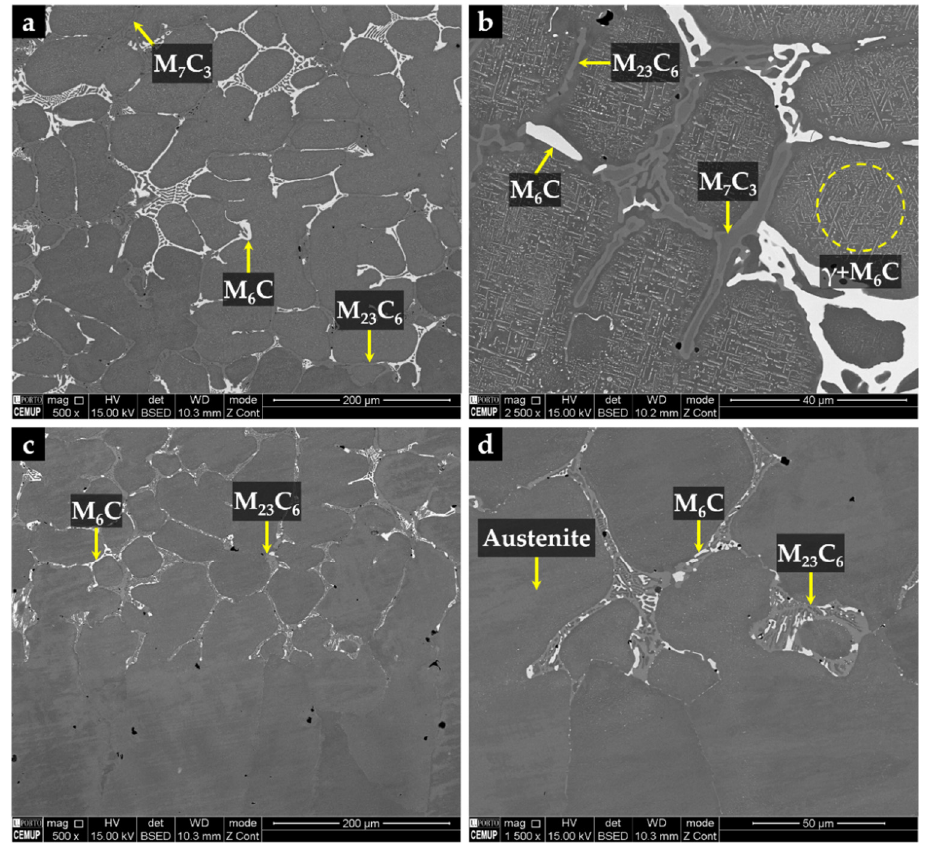
Figure 20. SEM-BSE images of the microstructure of CZ3 composite zone: ( a ) multi-phase interdendritic network of (Fe,Cr,W) 7 C 3 , (Fe,Cr,W) 23 C 6 , and (Fe,W,Cr) 6 C, ( b ) higher magnification of ( a ) showing fine precipitation of (Fe,W,Cr) 6 C inside the γ matrix, ( c ) bonding interface free of discontinuities, and ( d ) higher magnification of ( c ) showing the interdendritic precipitation at the bonding interface.